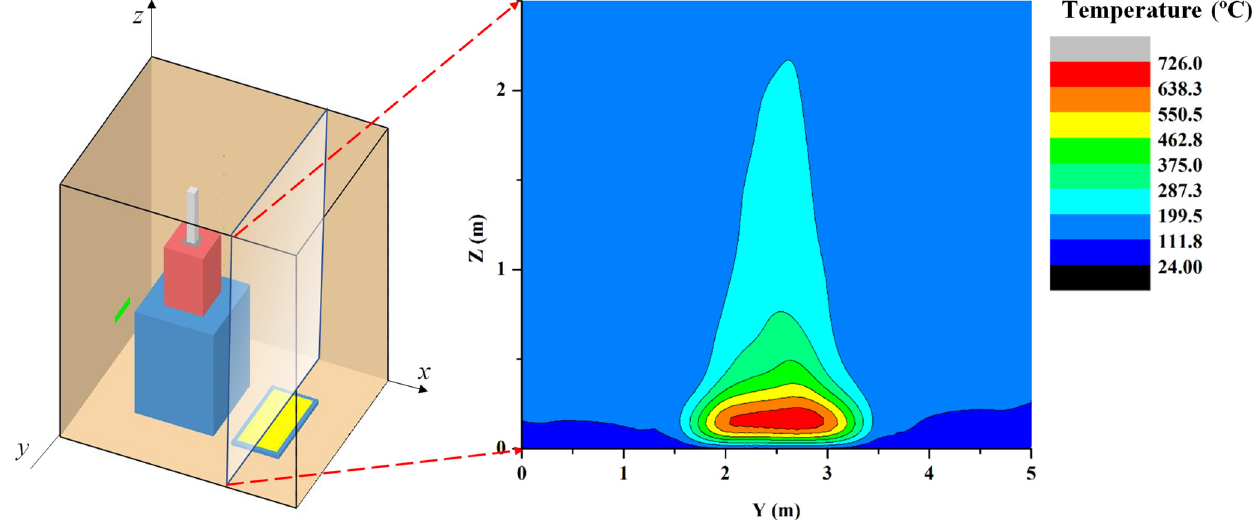
Figure 8. Mean centerline temperature profile for postulated methanol pool.